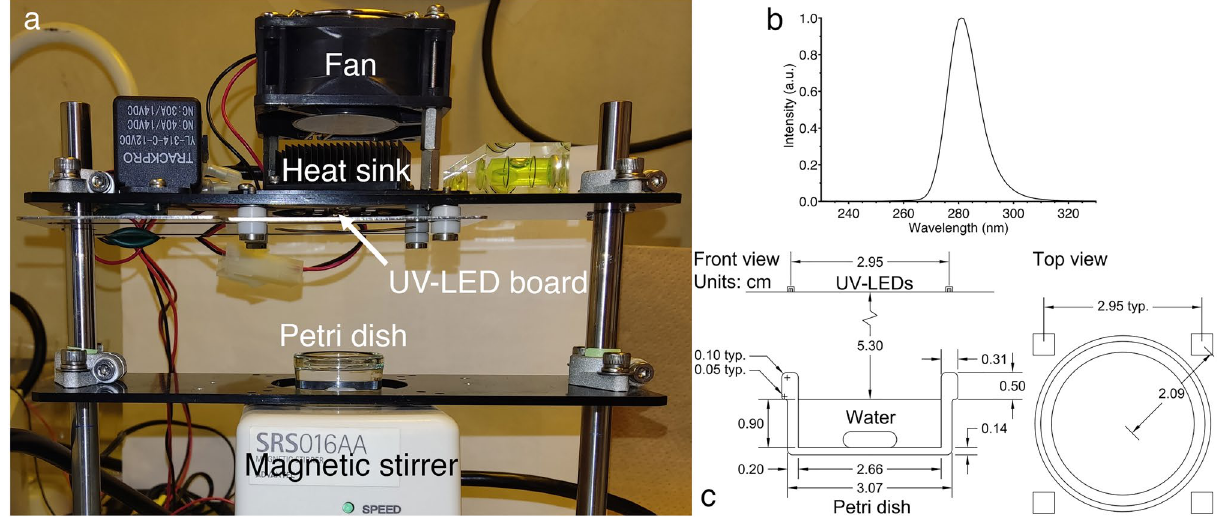
Figure 1. ( a ) UV-LED apparatus. ( b ) Emission spectrum of the UV-LED board, measured using a spectroradiometer. ( c ) Dimensions of the UV-LED setup under the irradiation